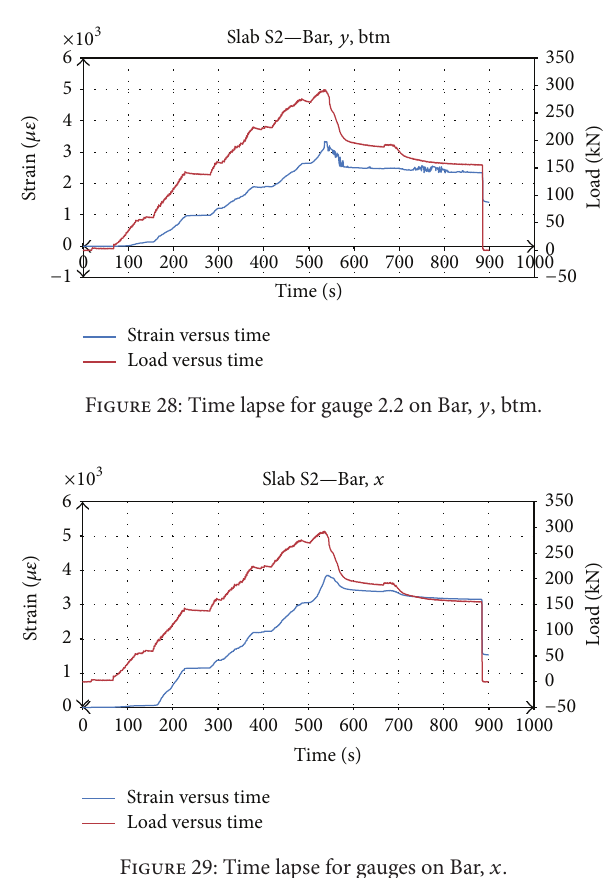
Figure 29: Time lapse for gauges on Bar, 𝑥 .